Question: What kind of plot is shown here?
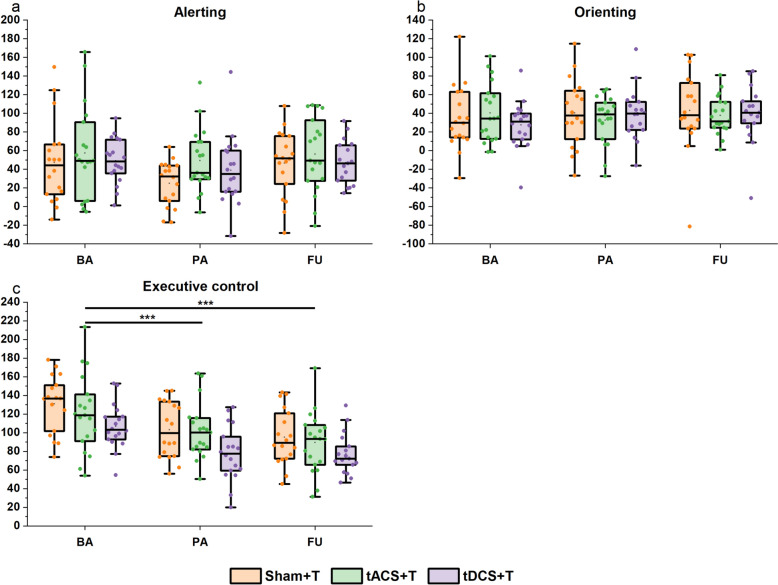
Answer: box